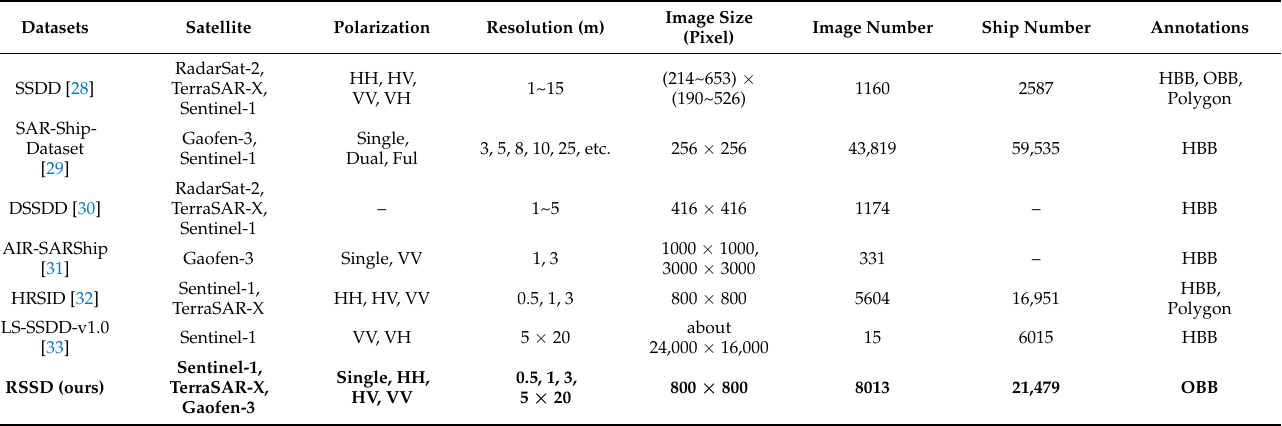
Table 1. Statistics of the six SAR ship detection datasets released in references [28–33] and our proposed